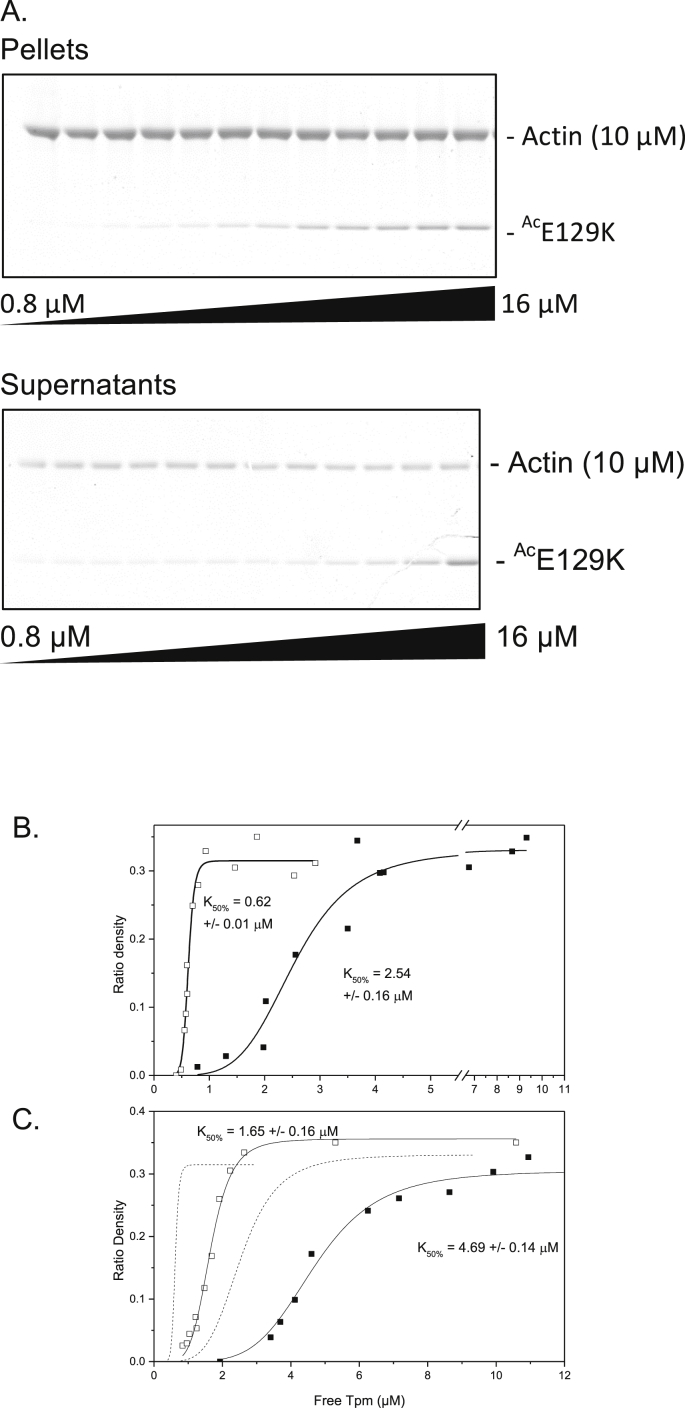
Actin binding assays of TpmCdc8. (A) Representive SDS/PAGE gels of pellet and supernatant fractions from the co-sedimentation assay of AceTpm-E129K. Ratio of density was measured by densitometry of co-sedimentation SDS/PAGE gels. The free Tpm concentration plotted against the ratio of density of actin to Tpm from the SDS-PAGE gel for Nt-acetylated (empty shapes) and non-acetylated (filled shapes) (B) WT-Tpmcdc8 and (C) E129K-Tpmcdc8. Binding curves were generated by fitting the Hill equation to the data and the K50% are the best fit values and standard error of the fit. Fits of wild type proteins (B) are shown in (C) as dotted lines for comparison.